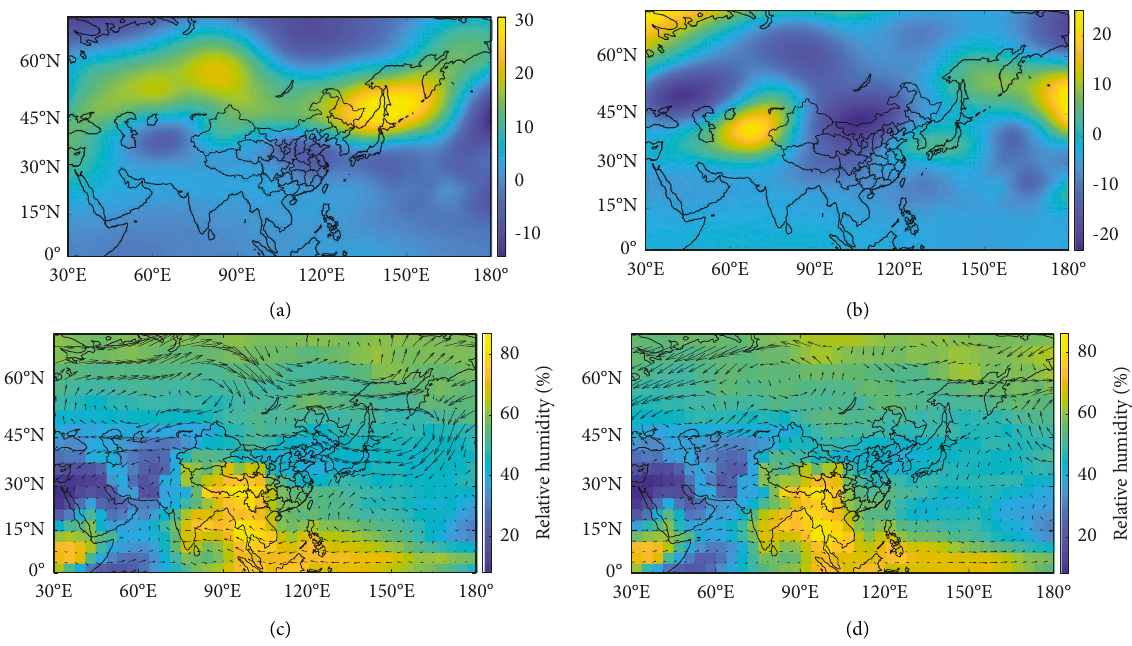
Figure 9: (a) ∼ (b) The distance between the 500hPa pressure field in the high and low ground-flash years; (c) ∼ (d) 500hPa wind field averages for high-value and low-value years, and the color-filled graphs are relative humidity